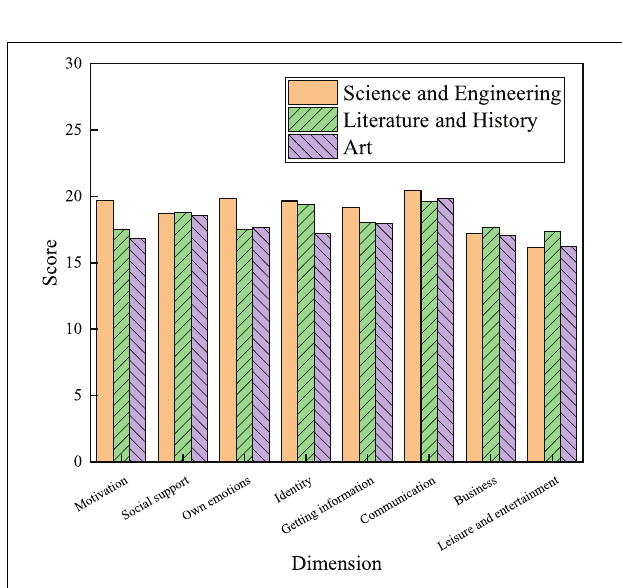
FIGURE 8 | Influences of gender on the use of network buzzwords by college students.